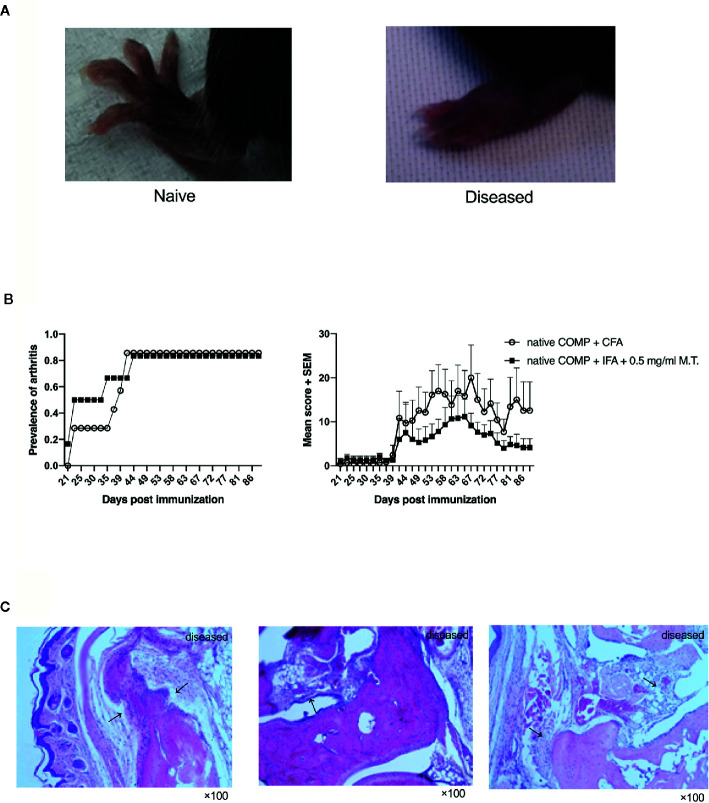
Native COMP induces arthritis in B6N mice with high incidence and severe arthritis. (A) The arthritis joint phenotype of B6N mice. (B) B6N mice were immunized with native COMP emulsified in CFA (n=7) or IFA+0.5 mg/ml M.T. (n=6), and monitored for prevalence and clinical score of arthritis. (C) Histological analysis of ankle joint of B6N mice with COMP-induced arthritis at the end of the experiment. Sections were stained with H&E staining. Prominent synovial hyperplasia, inflammatory cells infiltration and cartilage and bone destruction in mice immunized with native COMP+CFA. All images were taken at ×100 magnification.